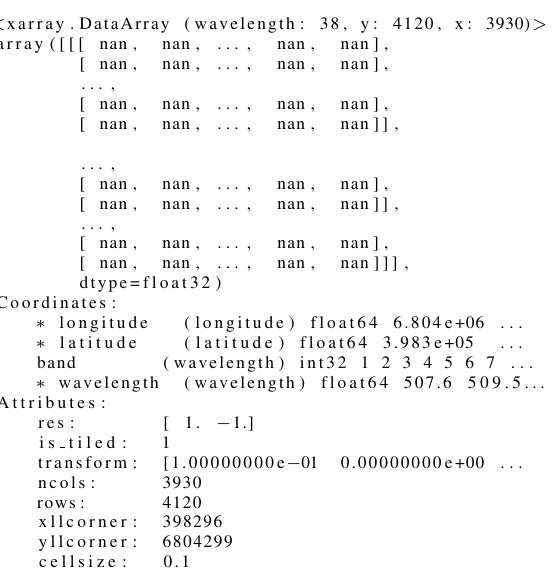
Figure 3. Simple print-command to see what the cube holds inside.